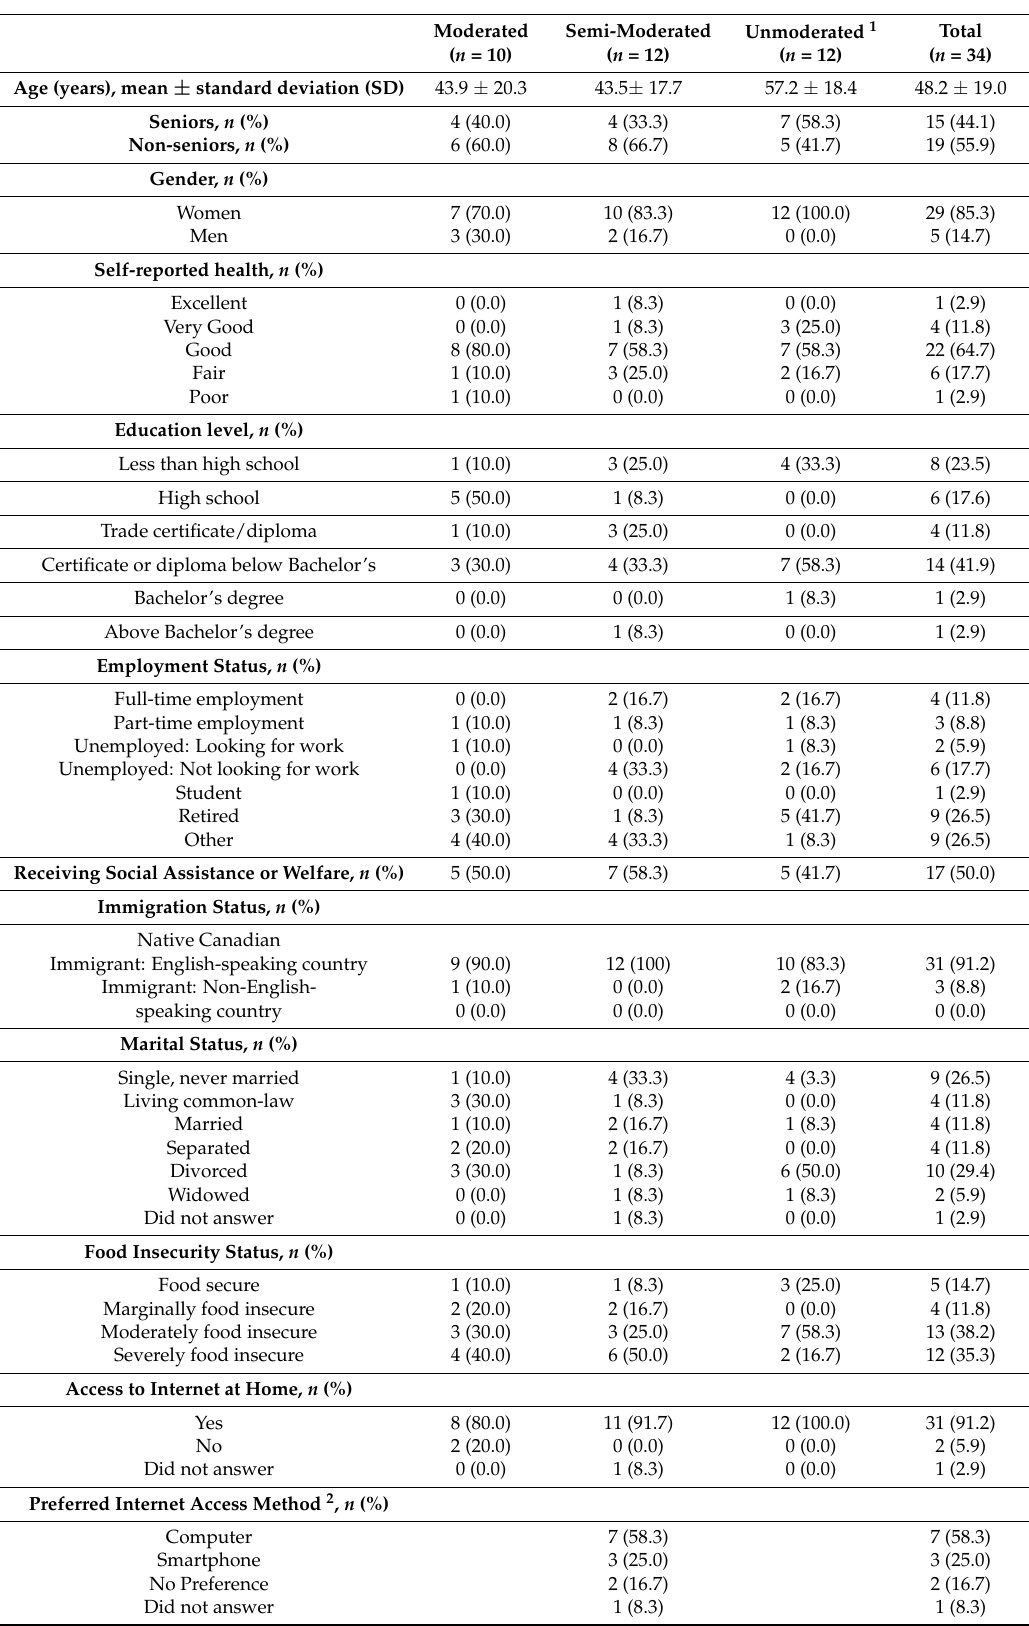
Table 2. Participant characteristics according to moderation